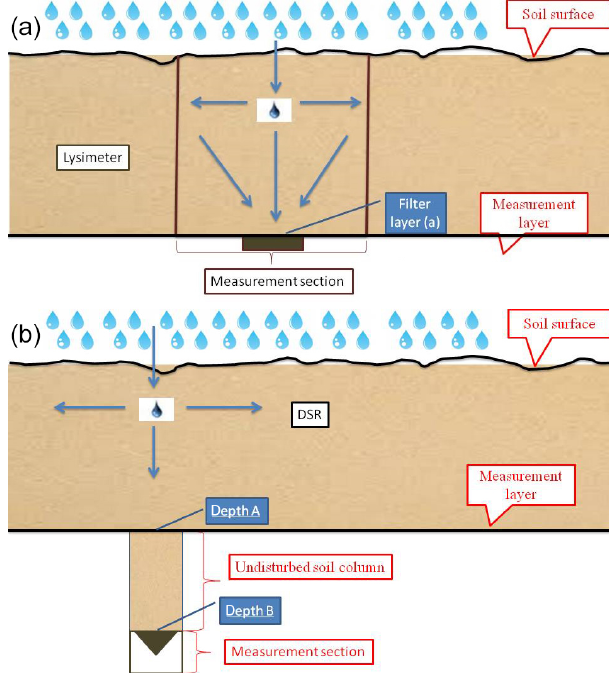
Figure 1. Schematic diagram of conventional lysimeter (a) and the new lysimeter (b)